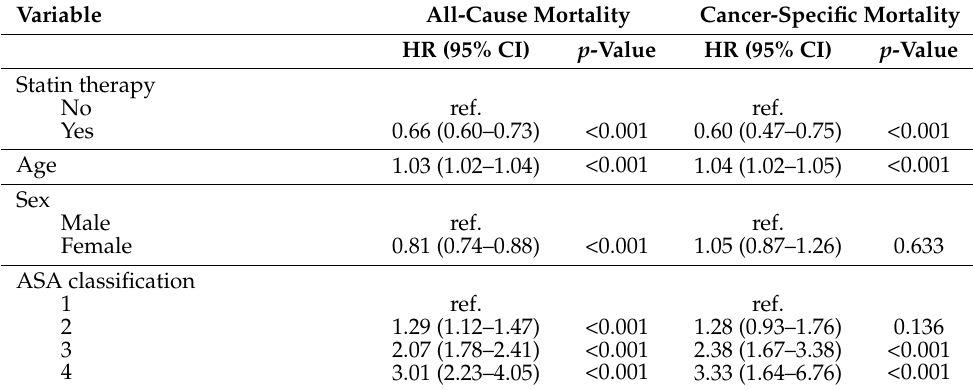
Table 4. Hazard Ratio for 5-year all-cause and colorectal cancer-specific mortality after elective rectal cancer